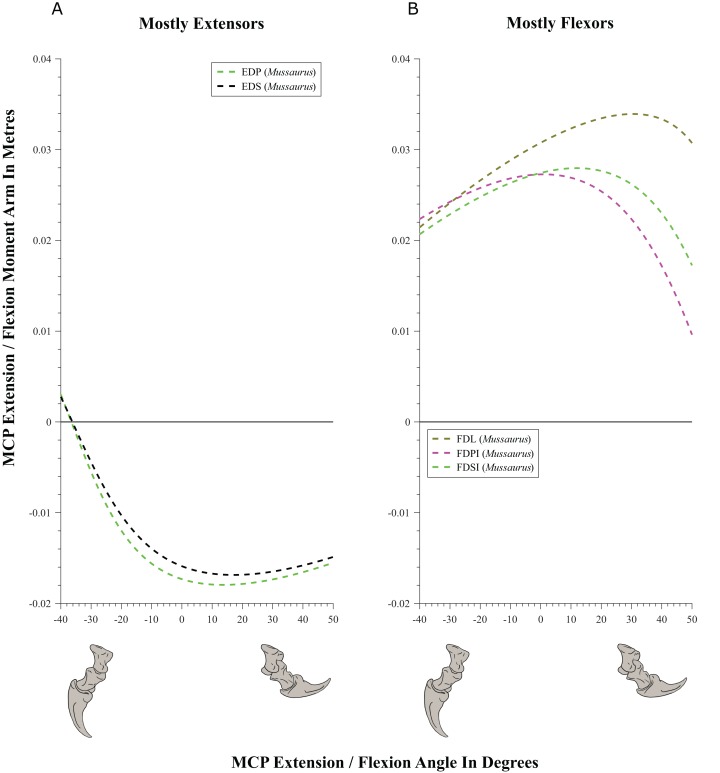
Extension/flexion moment arms (not normalized) around the metacarpo-phalangeal joints (MCP), plotted against extension/flexion joint angles for Mussaurus.(A) Mostly extensors; (B) mostly flexors. Negative moment arms and joint angles correspond to extension, while positive values correspond to flexion. For muscle abbreviations see Table 1.